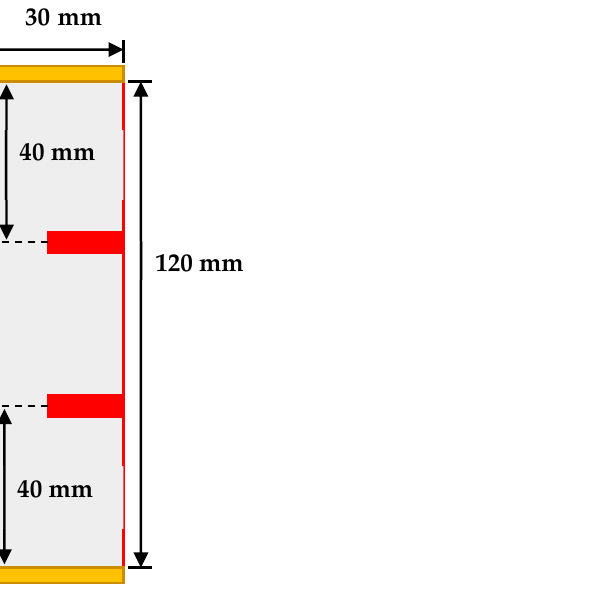
Figure 1. Rectangular cavity with 2 symmetrically placed fins. Table 1. Thermophysical properties of Lauric Acid.